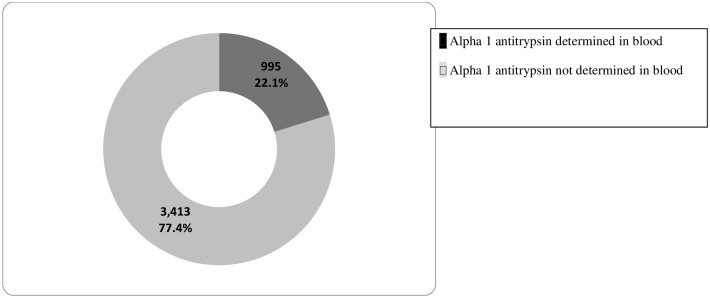
Distribution of AAT level determination in the blood.Of the analyzed cohort, only 995 (22.5%) patients underwent AAT determination.